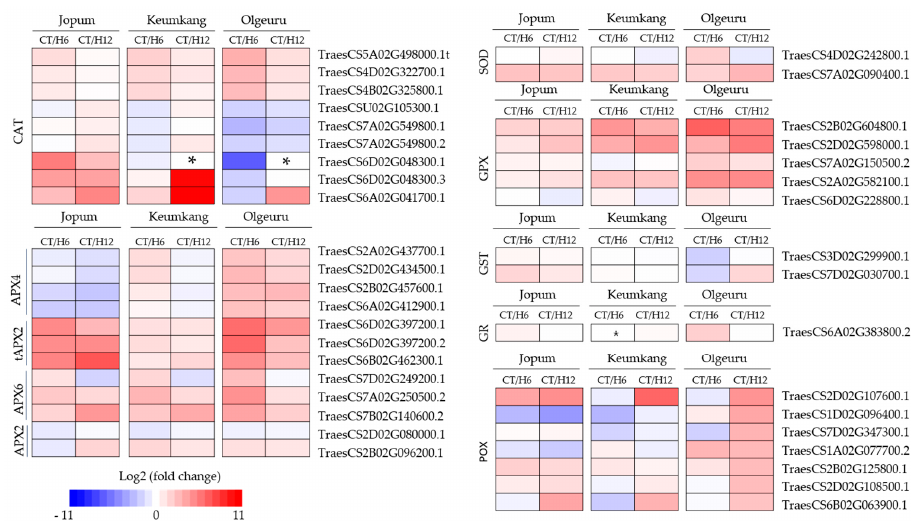
Figure 5. Heatmap of the temporal expression pattern of selected genes involved in ROS scavenging in response to heat stress. Upregulation is indicated in red; downregulation is indicated in blue; *, not evaluated. The scale of the color intensity is presented in the legend. CAT, catalase; APX, ascorbate peroxidase; SOD, superoxide dismutase; GPX, glutathione peroxidase; GST, glutathione S-transferase; GR, glutathione reductase; POX, peroxidase; CT, untreated control; H6, 6 h heat treatment; H12, 12 h heat treatment.